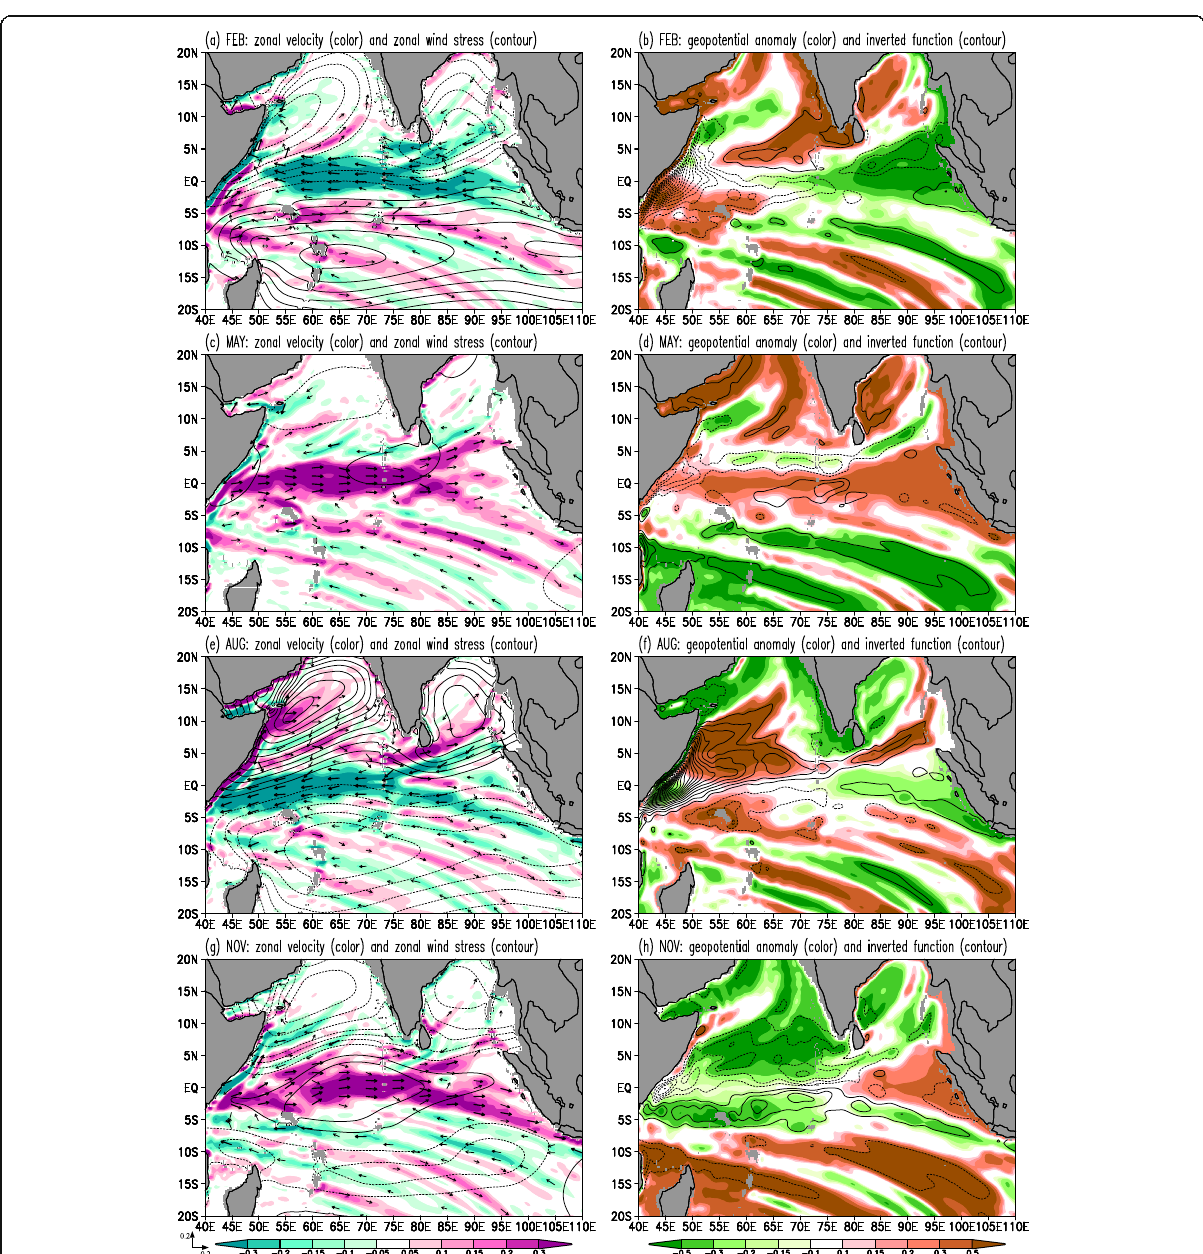
Fig. 1 Left panels: the zonal component of simulated velocity at the sea surface (color shading with a unit of m/s), the zonal component of wind stress in the model (solid and dotted contours for eastward and westward anomalies, respectively, with an interval of 0.02 N/m 2 ), and the velocity vector (arrows in units of m/s) in the middle of a February, c May, e August, and g November from “ Year 20 ” of our climatological model experiments. When under 0.2 m/s, the magnitude of simulated velocity vectors in left panels is indicated either by arrow length or, for greater values, by heavy arrows of uniform length. Right panels ( b , d , f , and h ): same as left panels except for simulated sea surface geopotential anomaly (color shading with a unit of m 2 /s 2 ) and PV-inverted function at the sea surface (solid and dotted contours represent positive and negative values, respectively, with an interval of 20,000 m 2 /s). The PV-inverted function may be interpreted as geostrophic streamfunction in off-equatorial regions. The sea surface quantities have been reconstructed from the model results of fundamental six baroclinic modes